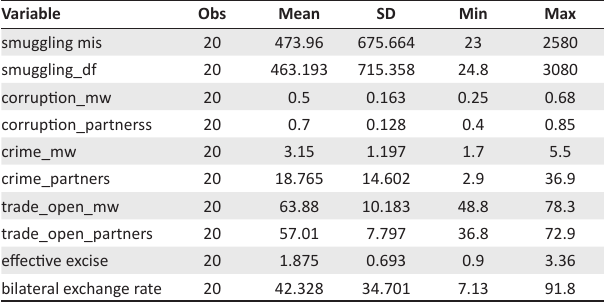
TABLE 1: Summary statistics.